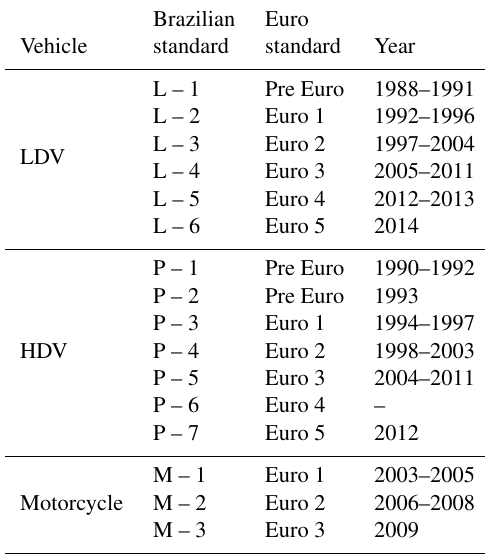
Table 2. Proposed equivalence of emission standards used in São Paulo